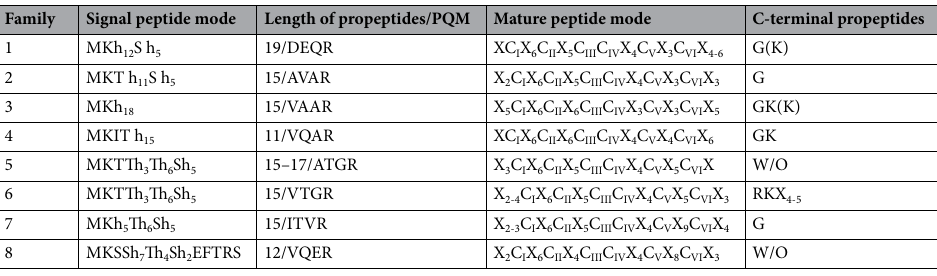
Table 1. Sequence diversity of the predicted 6-cys ICK motif toxins in H. venatoria. In the signal peptide mode, ‘h’ indicates hydrophobic residue, and the Arabic numerals denote the number of residues. Capital letters indicate the corresponding amino acids. ‘C’ is cystine, ‘X’ is any residue but cystine, and ‘W/O’ denotes no putative C-terminal